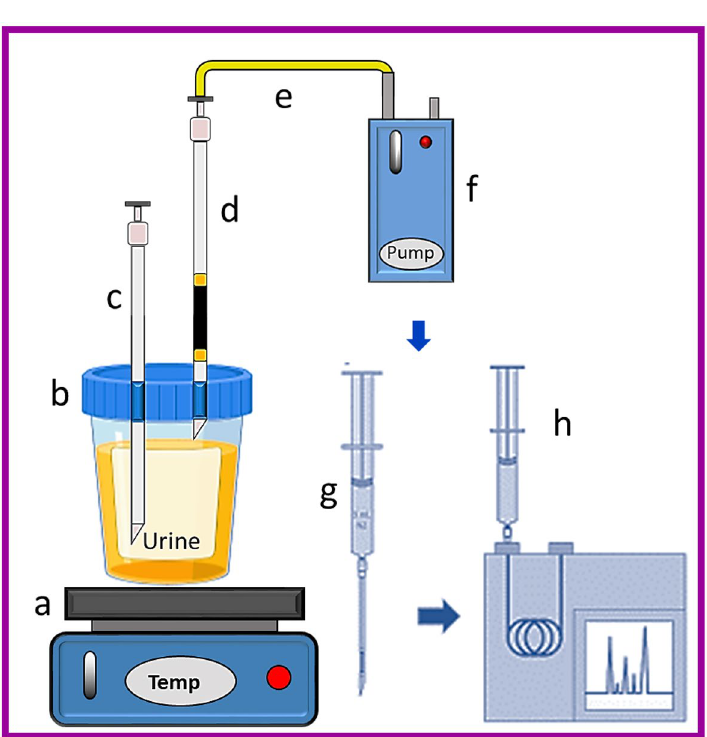
Figure 2. Schematic diagram of headspace sampling and analysis of the amphetamine compounds by Zr-UiO- 66-PDC@NTD technique: ( a ) heater-Stirrer, ( b ) urine vial, ( c ) needle, ( d ) packed NTD, ( e ) tube, ( f ) pump, ( g ) NTD-GC needle, ( h )